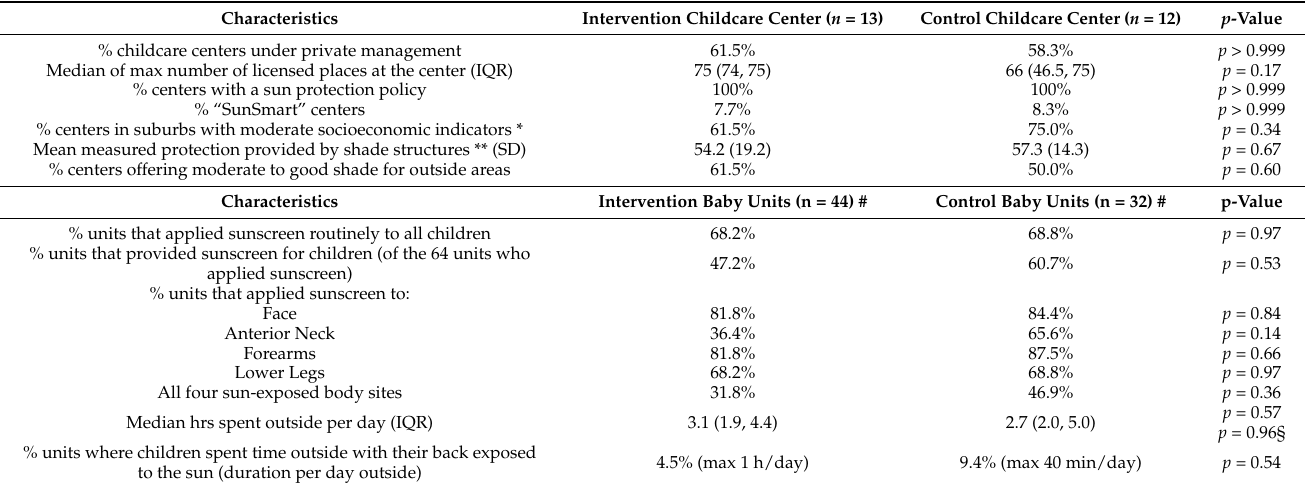
Table 1. Baseline characteristics of the 25 childcare centers participating in the cluster randomized controlled trial in Townsville,